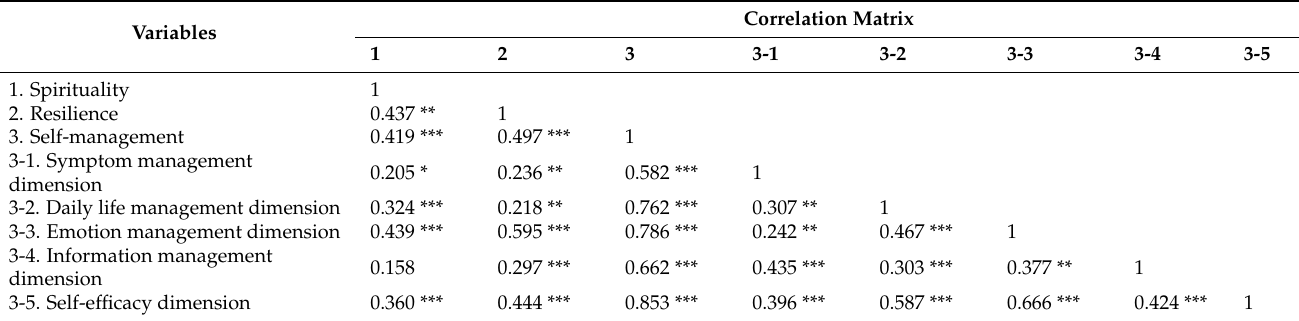
Table 3. Partial correlations between target variables after controlling potential confounders #. Variables